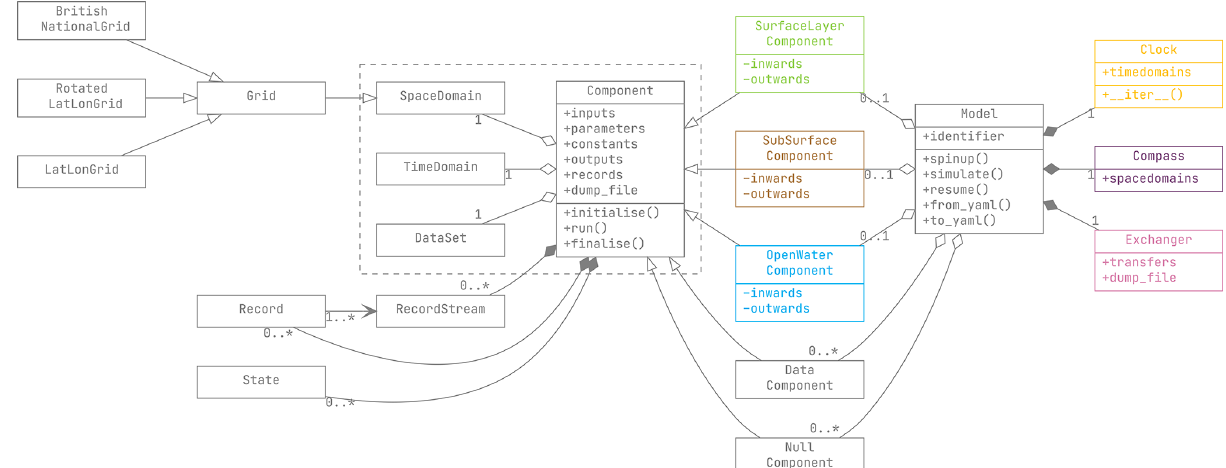
Figure 2. UML class diagram of the unifhy Python